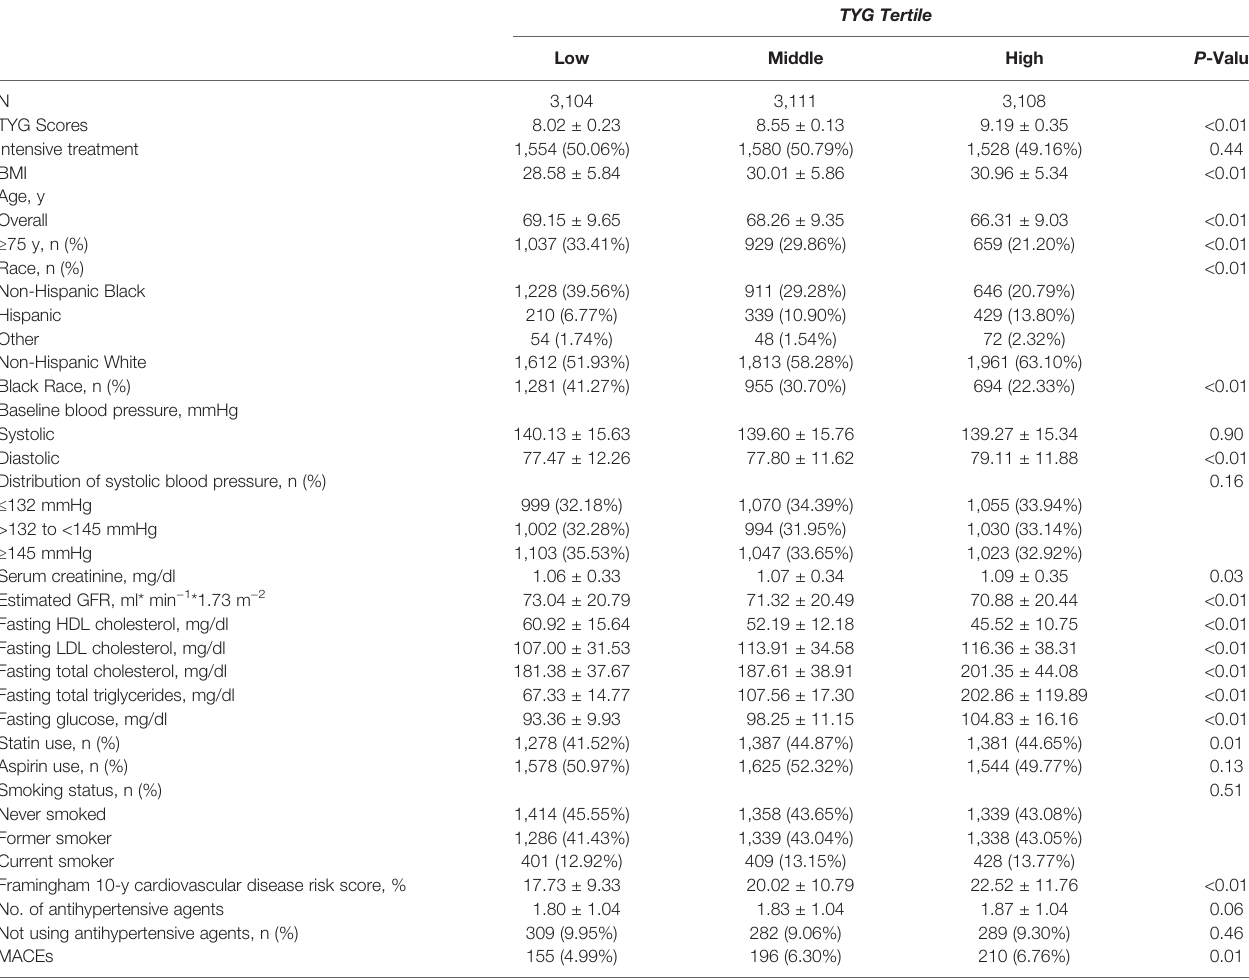
TABLE 1 | Baseline characteristics and crude end points of the study